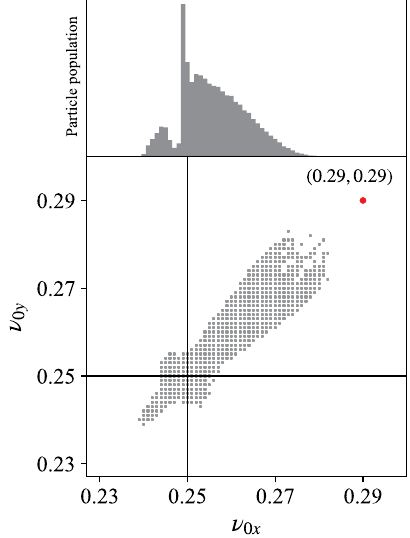
FIG. 8. Incoherent tune spread of a Gaussian beam at ν 0 x ¼ ν ¼ 0 . 290 (red dot) where the emittance growth is negligible. 0 y The rms tune depression is adjusted initially to η ¼ 0 . 9 , the same as in the case of Fig.